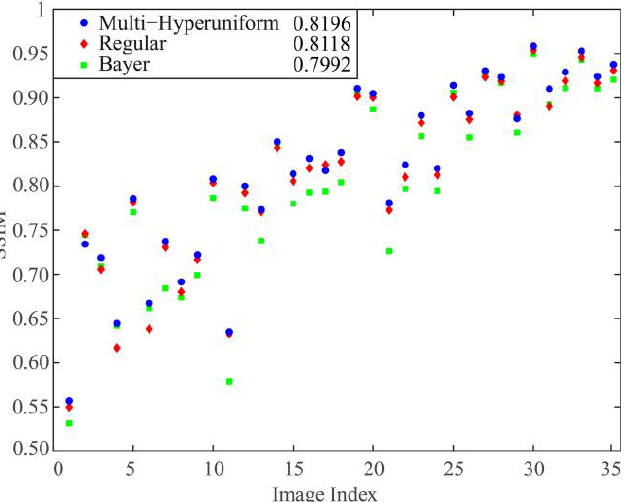
Figure 5. The SSIM values of the reconstructed chromatic images using multi-hyperuniform ( blue dot ), regular ( red diamond ), and Bayer ( green square ) sampling patterns. The averaged values of 35 image SSIMs are listed on the label.